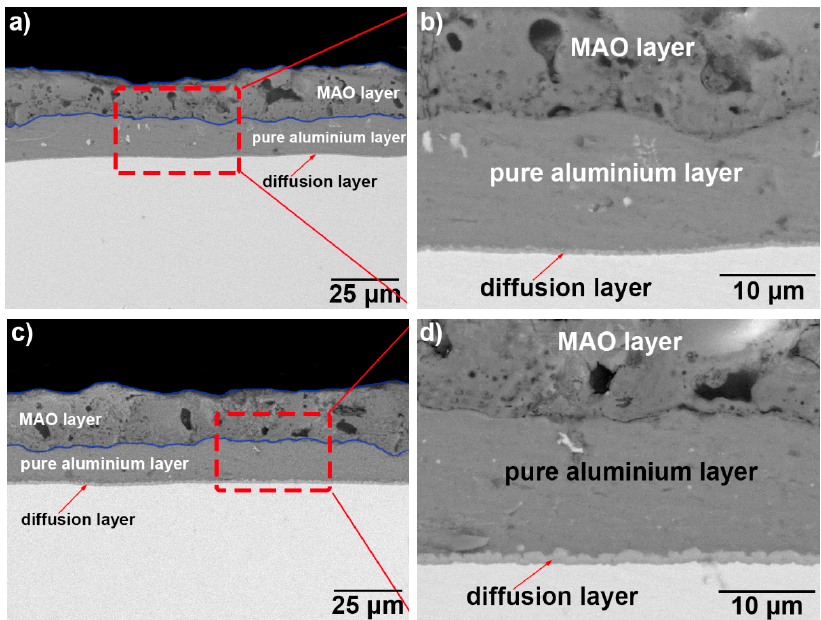
the hot-dip aluminised coating on the TA2 substrate: ( a , c ) T-1 sample, ( b , d ) T-2 sample. the hot ‐ dip aluminised coating on the TA2 substrate: ( a ) and ( c ) T ‐ 1 sample, ( b ) and ( d ) T ‐ 2 sample.